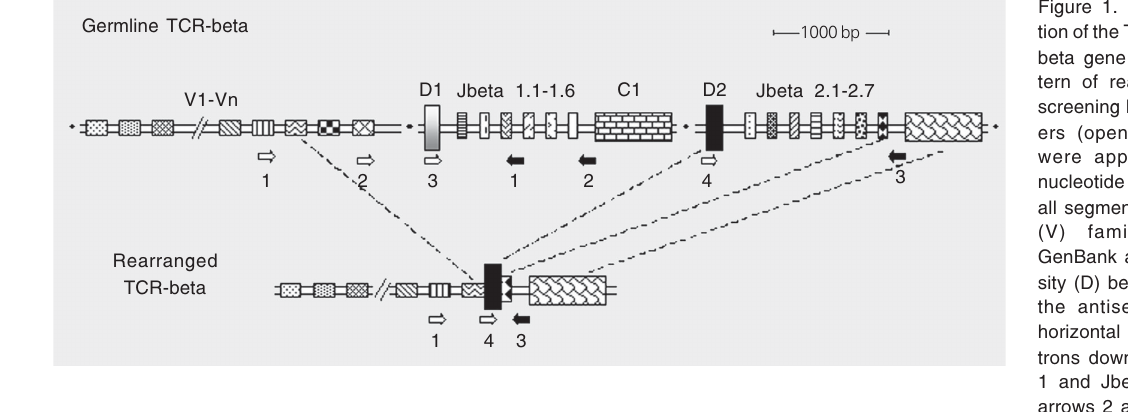
1).Table 1. Morphologic and immunophenotypic evaluation of peripheral blood from patients with an unconfirmed diagnosis of adult T-cell leukemia/lymphoma (group I).